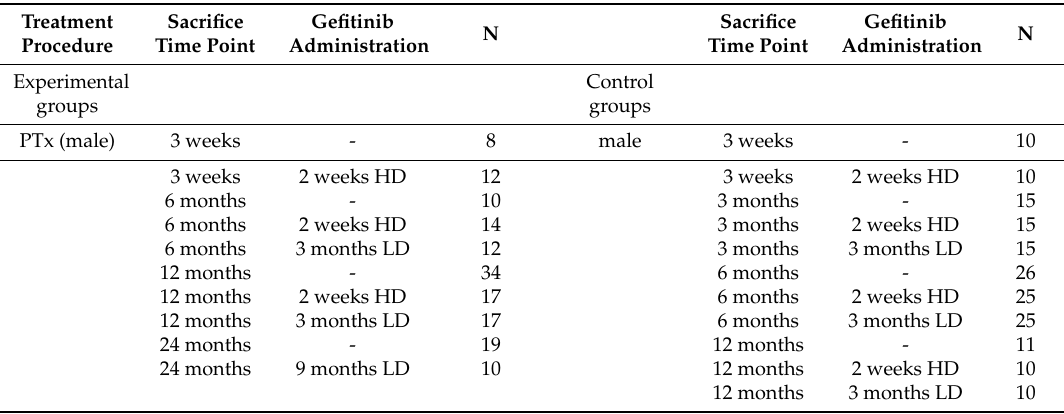
Table 4. Experimental design of investigated models of